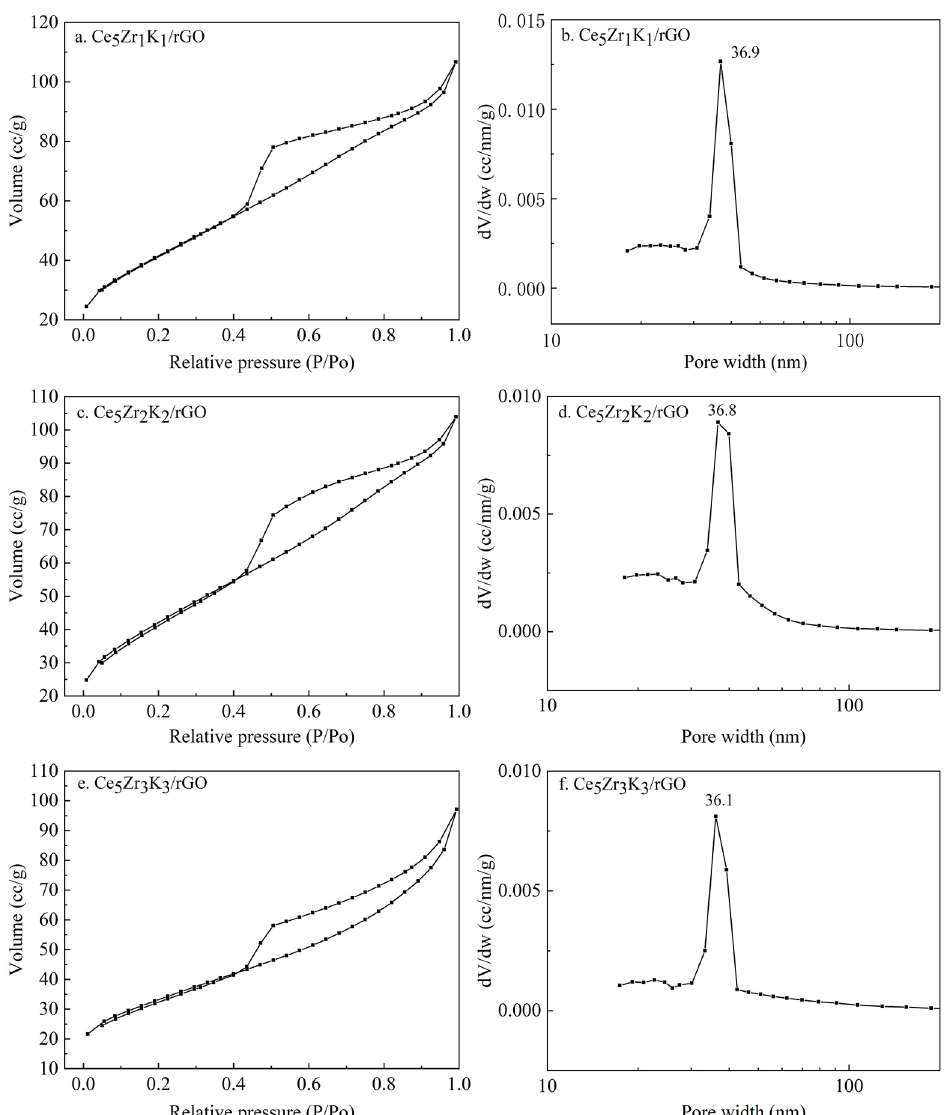
Figure 5. N 2 adsorption isotherms and pore size distributions of CeZrK/rGO catalysts .